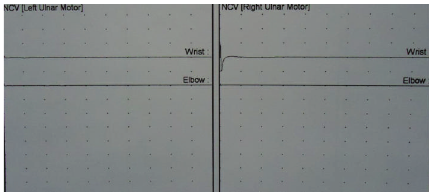
Figure 3: Nerve conduction study showing no motor response in bilateral ulnar